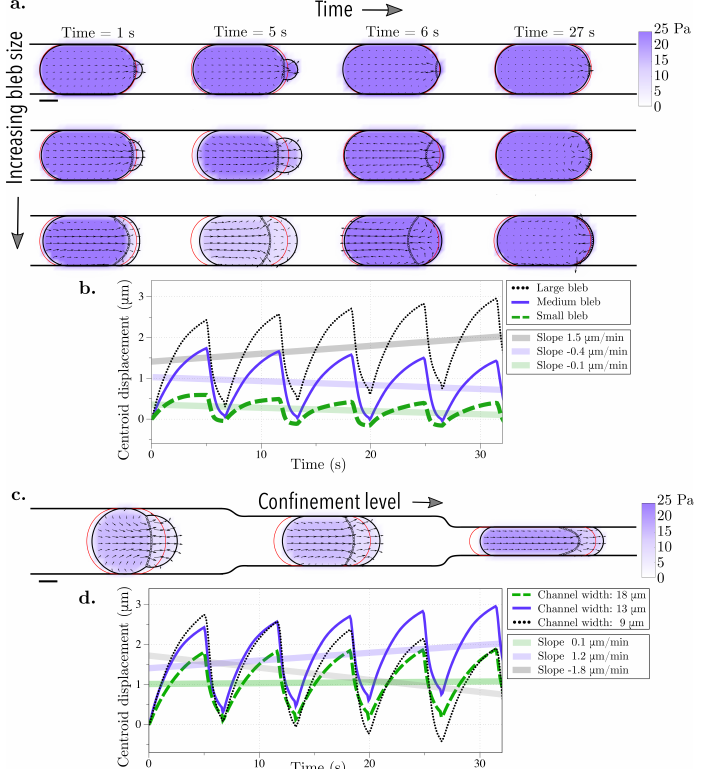
Figure 3. Bleb cycle in a straight rigid channel. Bleb expansion and retraction over one cycle (approximately 7 s) and after 4 bleb cycles (27 s) for ( a ) three different bleb sizes (bleb neck sizes of 4, 8, and 16 µ m) and ( c ) three different channel widths (18, 13, and 9 µ m). The vector field represents the intracellular fluid velocity, and the scalar color field represents cytosolic pressure. The initial position of the membrane is shown in red. The current position of the membrane is shown in black, and the position of the old cortex are denoted with black circles. ( b , d ) The straight line in the centroid horizontal displacement is a least squares fit to the data over 4 bleb cycles. ( b ) The slopes for the small bleb, medium, and large bleb, respectively, are − 0.1, − 0.4, and 1.5 µ m/min. ( d ) The slopes for linear fits of simulation data for channel heights of 18, 13, and 9 µ m are 0.1, 1.2, and − 1.8 µ m/s,